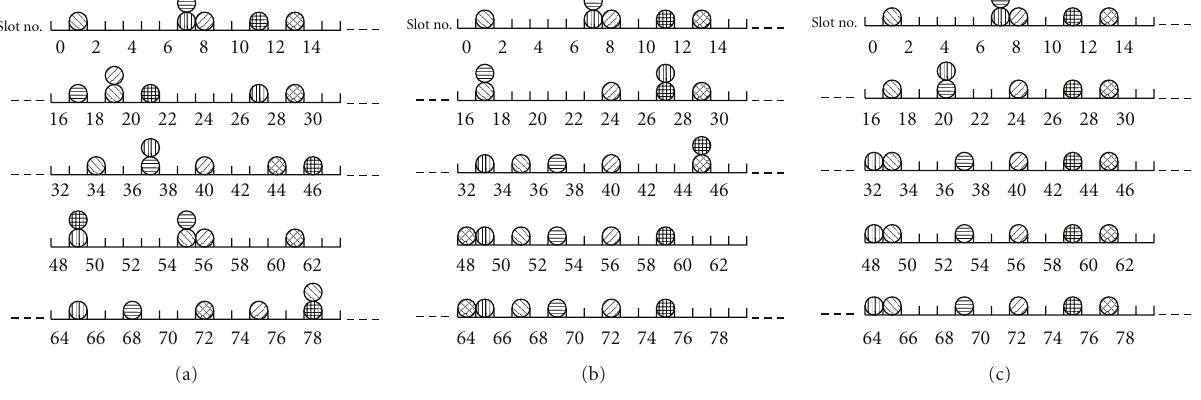
Figure 1: An example of CSMA/CA (a), CSMA/ECA (b), and ZeroCollision (c)